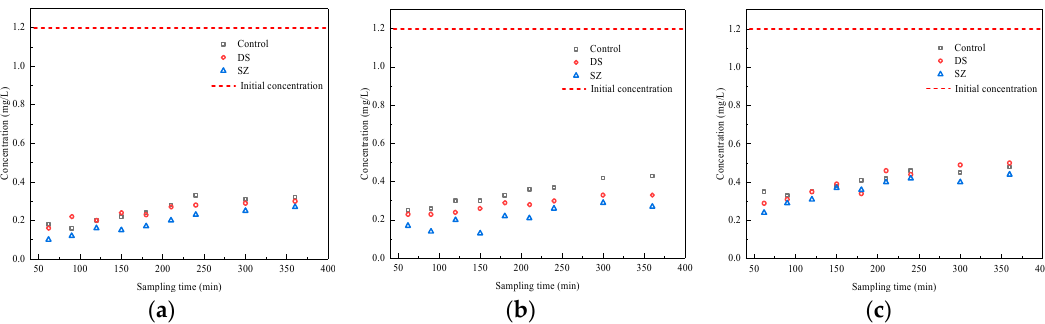
Figure 3. Concentration of total phosphorous (TP) using bioretention systems with the Control column, DS column, and SZ column under 1a ( a ), 5a ( b ), and 10a ( c ) rainfall intensities.